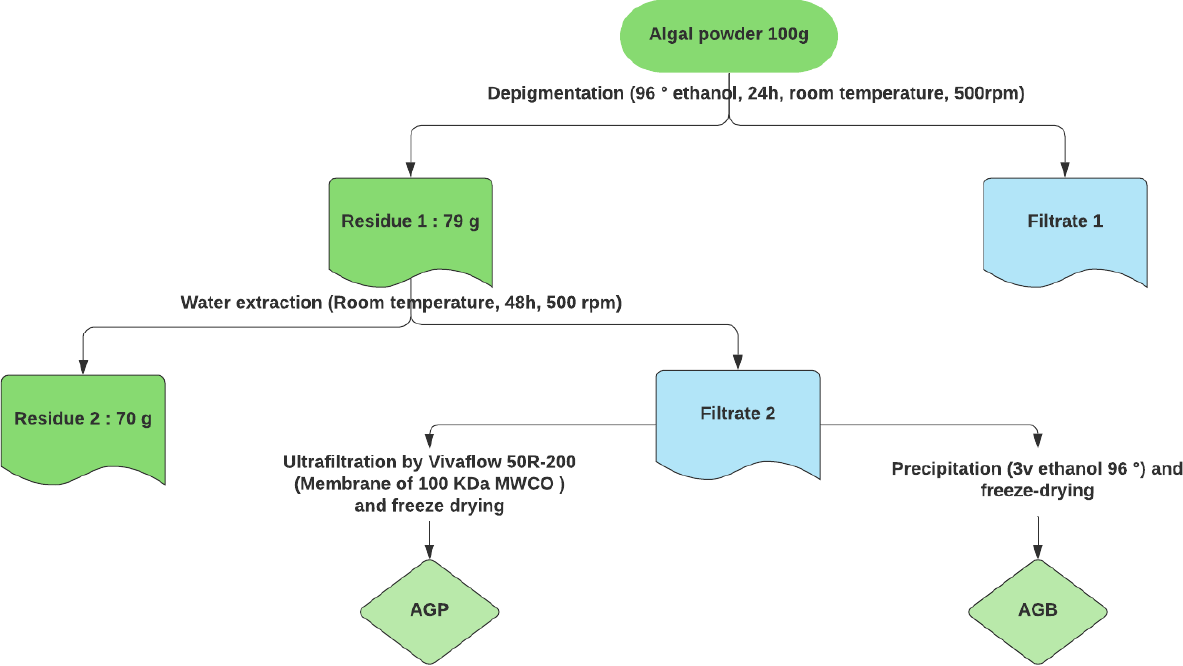
Figure 1. Process for extraction and purification of sulfated glycoproteins from C. decorticatum